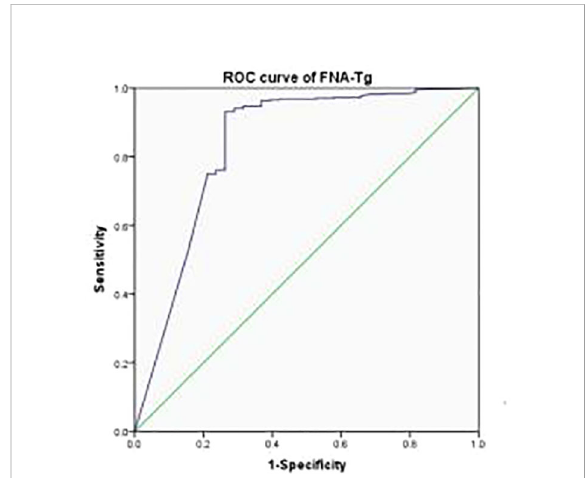
FIGURE 2 The ROC curve of FNA-Tg according to de fi nite status of the 448 lateral CLNs.